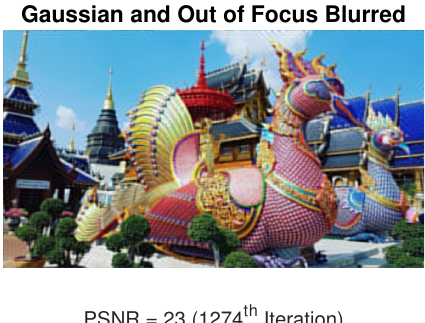
Figure 45. The reconstructed RGB image of all cases using the proposed method (2) with PSNR = 23.